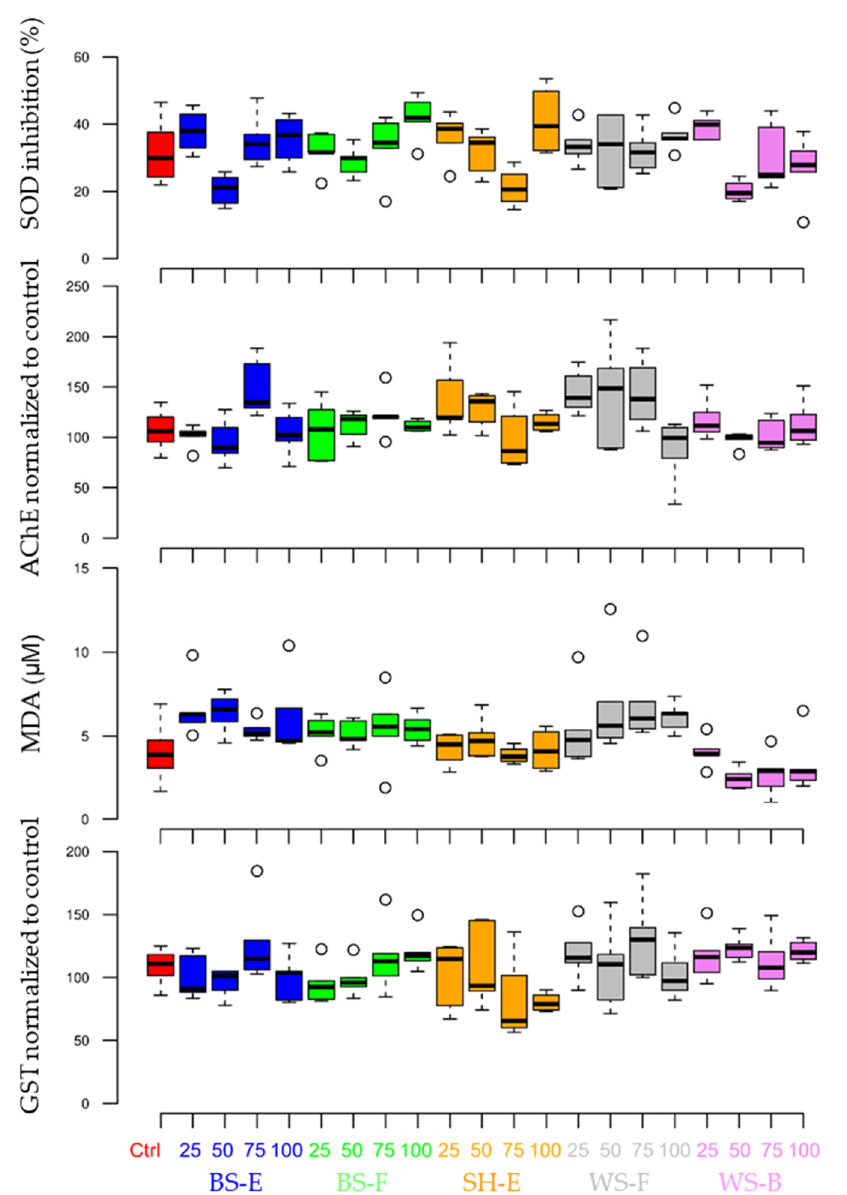
Figure 6. Measured biomarker values in earthworm Eisenia fetida after seven-day exposure to different ratios of ABAs in an artificial soil test.